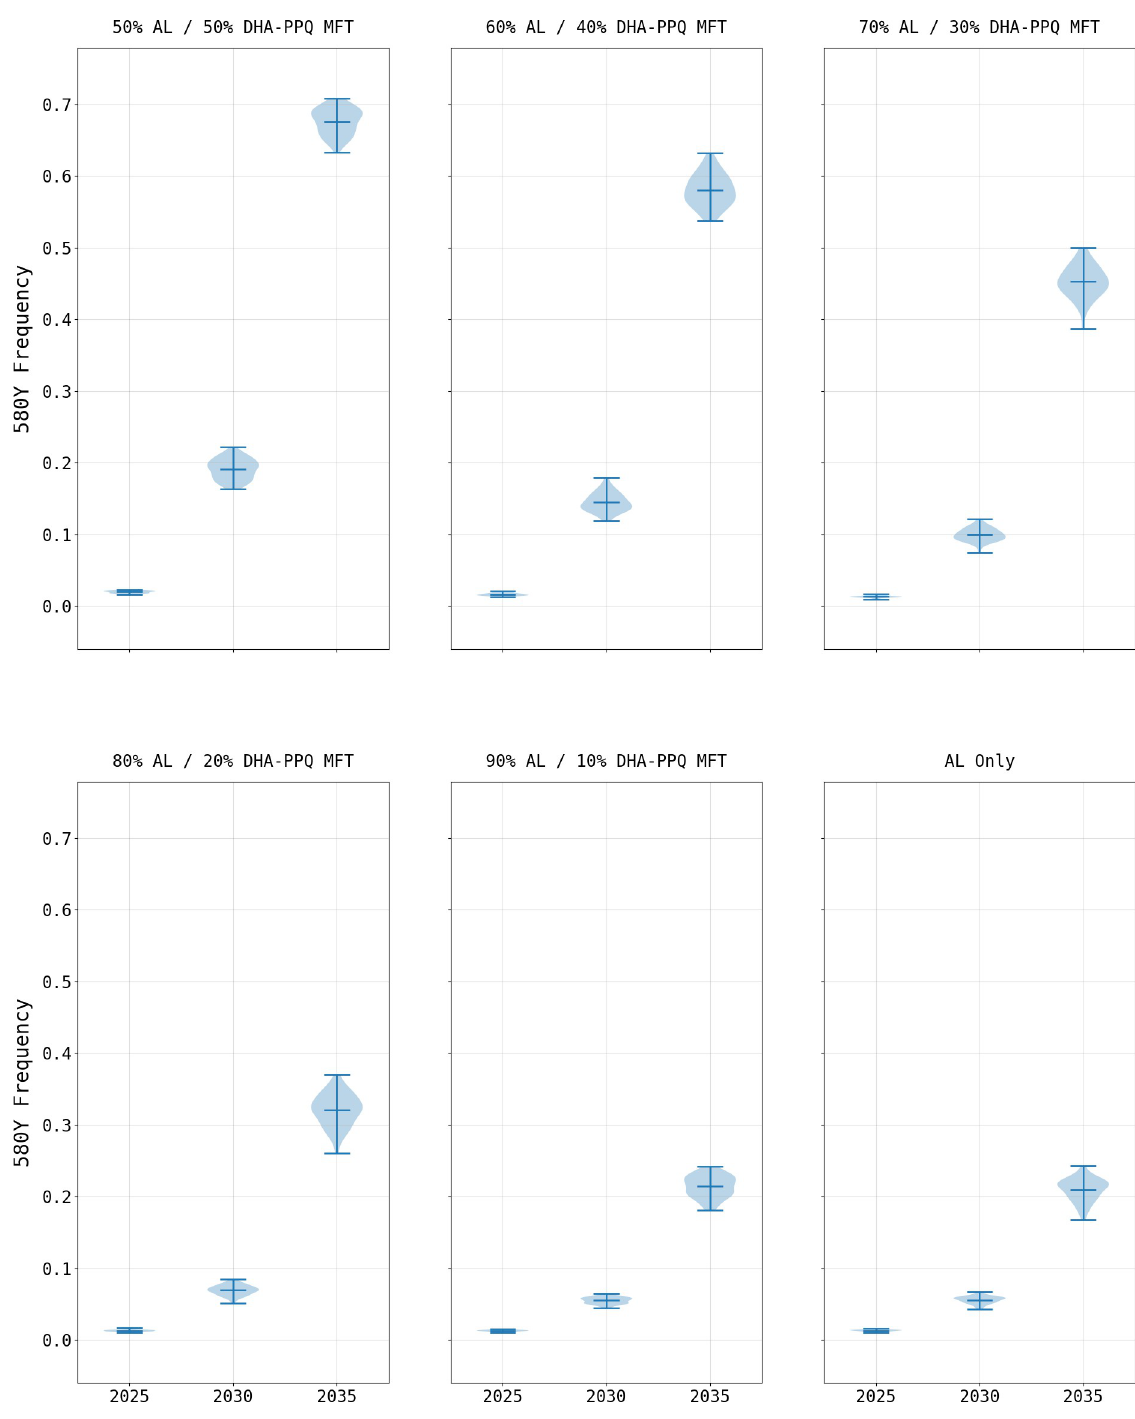
Fig 9. 580Y frequency under various MFT configurations (mean and range). The impact of changing the role of DHA-PPQ in an MFT policy. Lower DHA-PPQ use results in weaker selection pressure on 580Y alleles. The loss of PPQ efficacy due to plasmepsin-2 , 3 double-copy emergence influences the rate at which the 580Y frequency